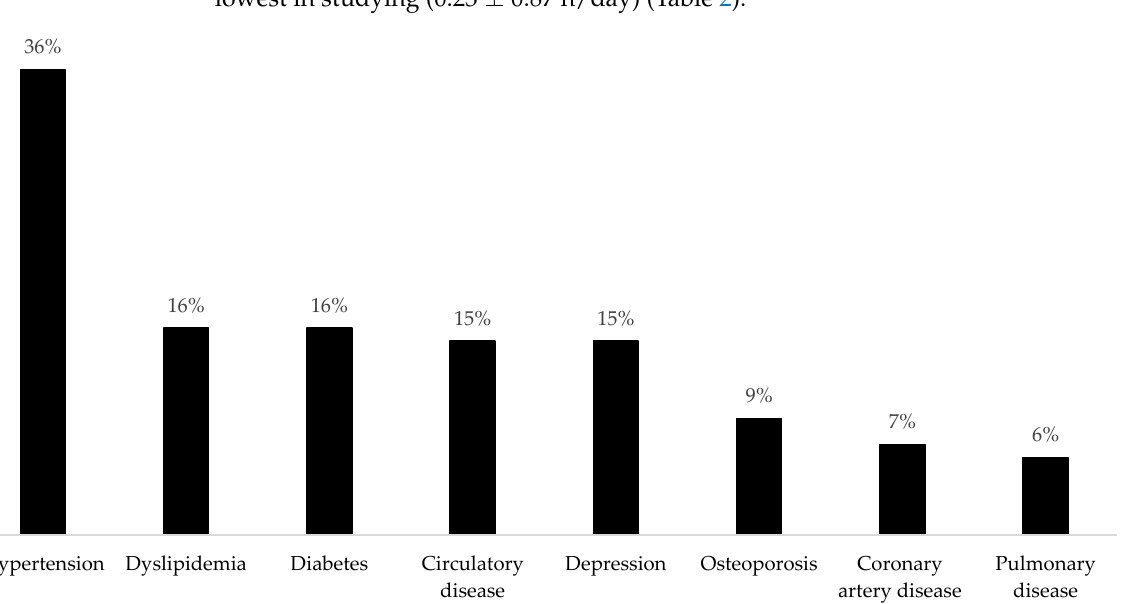
Figure 1. Prevalence of chronic disease of adults attending basic health units. São José dos Pinhais, Paraná, Southern Brazil, 2019 (n = 779).